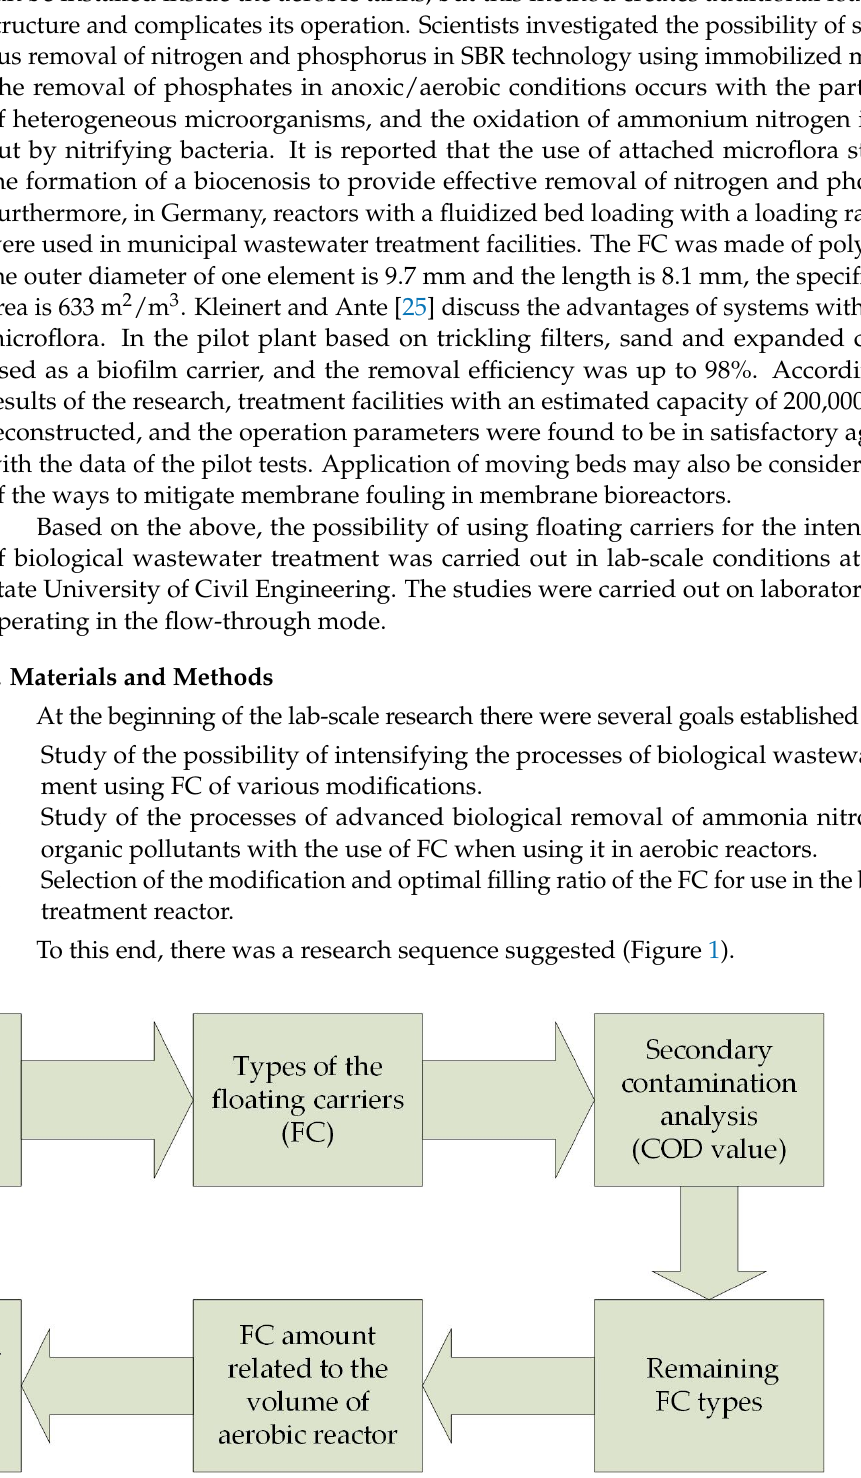
Figure 1. Research